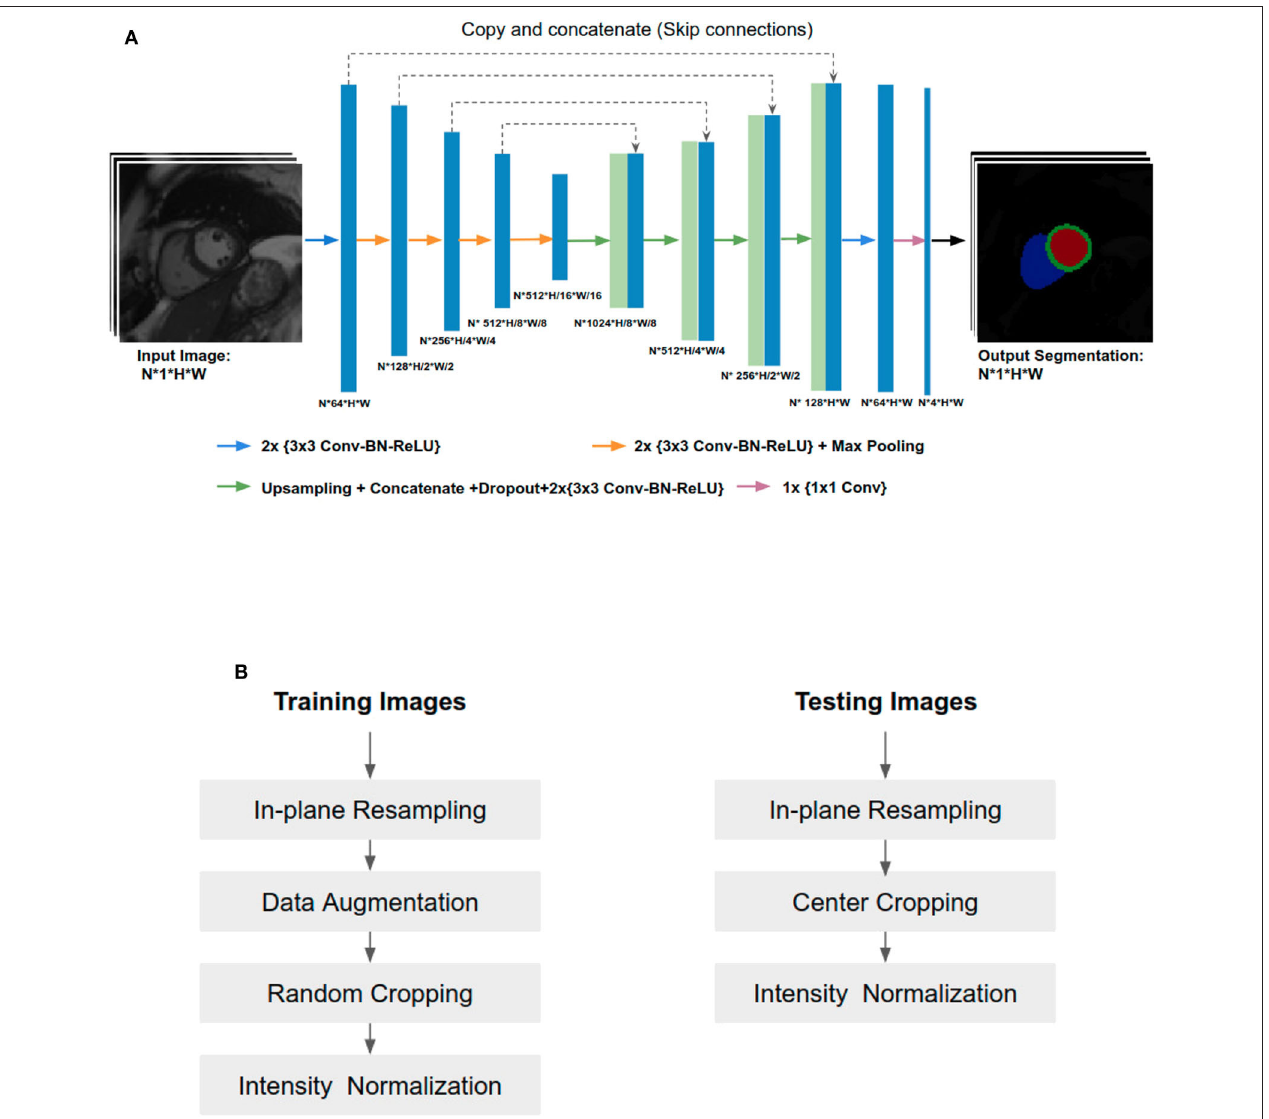
FIGURE 1 | (A) Overview of the network structure. Conv, Convolutional layer; BN, Batch normalization; ReLU, Rectified linear unit. The U-Net takes a batch size of N 2D CMR images as input at each iteration, learning multi-scale features through a series of convolutional layers, max-pooling operations. These features are then combined through upsampling and convolutional layers from coarse to fine scales to generate pixel-wise predictions for the four classes (background, LV, MYO, RV) on each slice. (B) Image pre-processing during training and